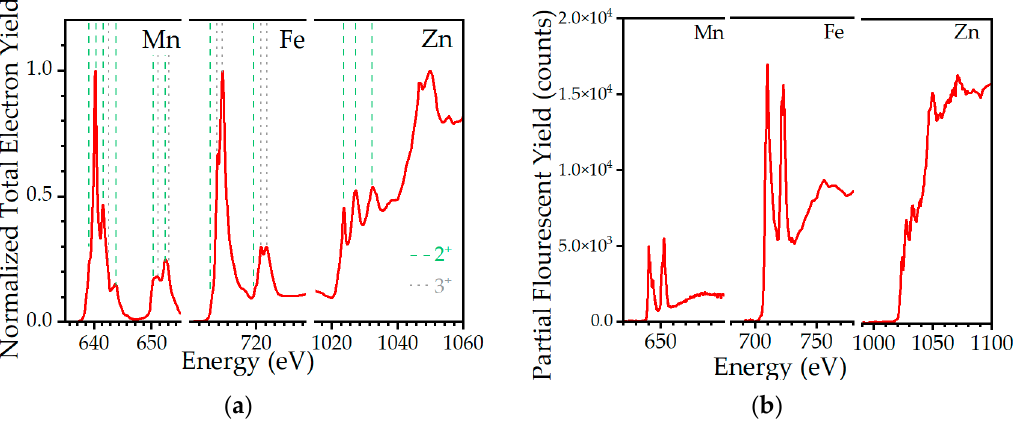
Figure 3. X-ray absorption spectra of nanoparticles grown in silicone. ( a ) The total electron yield spectra in the Mn, Fe, and Zn L absorption range. Green dashed lines indicate features characteristic of ions with 2+ oxidation states and gray dotted lines indicate features of 3+ oxidation. ( b ) The measured fluorescence yield of Mn, Fe, and Zn.